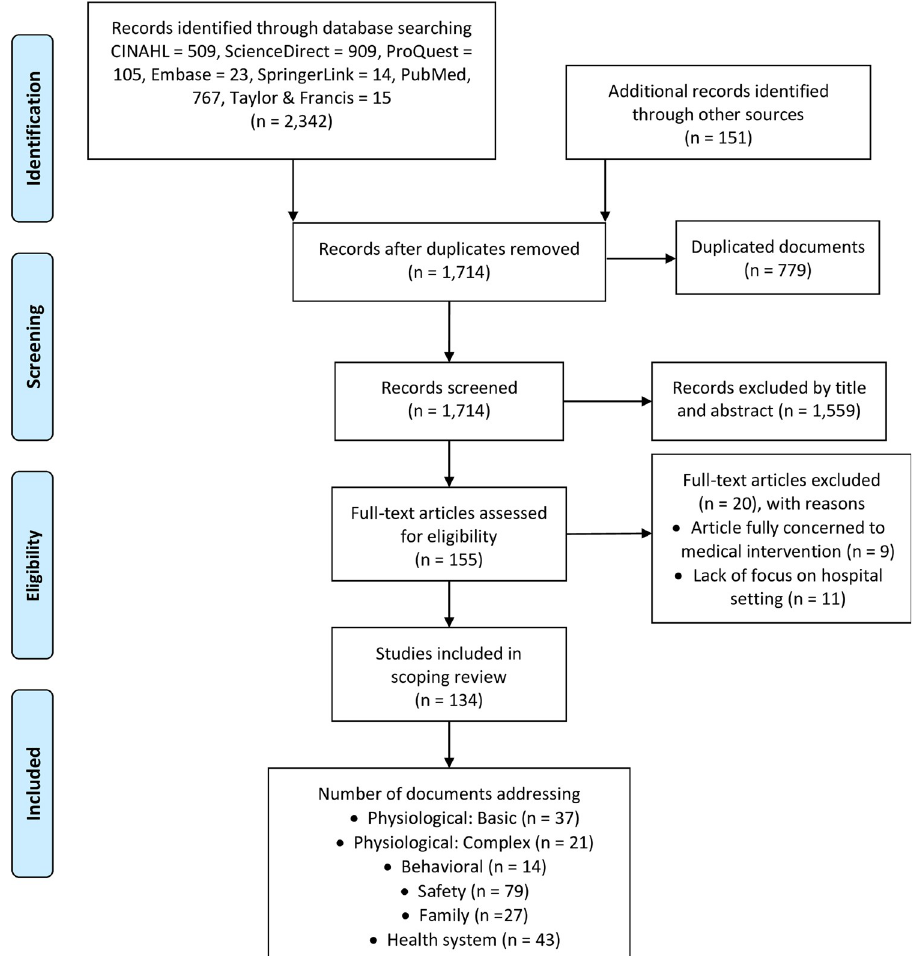
Fig 1. PRISMA flow diagram for the scoping review